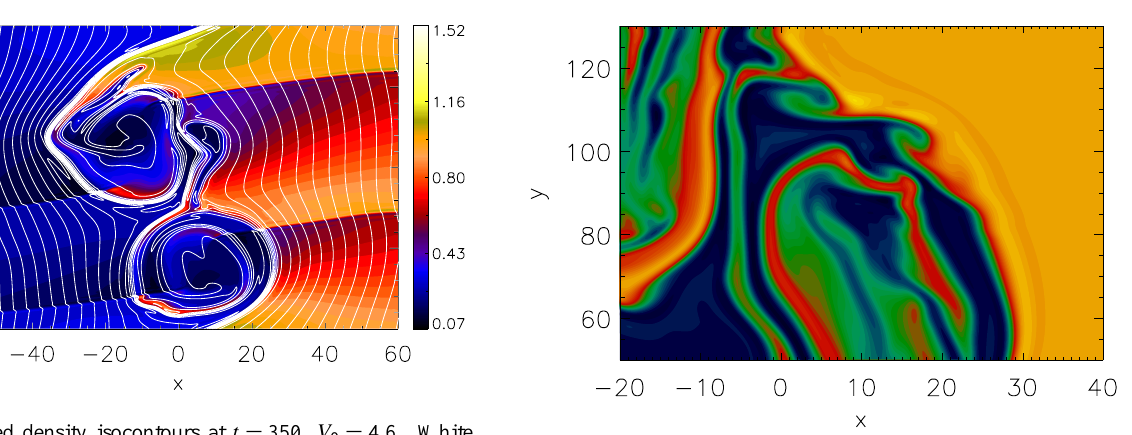
= 4 . 6. The point where the 0 shock is attached to the vortex is localized at x = 30, y =